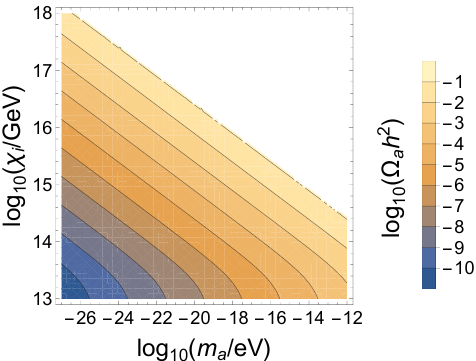
Figure 1. Relic density of ALP dark matter produced through misalignment, the oscillation of which began during the RD epoch, with H M pl = 2 . 44 × 10 18 GeV, Ω r h 2 = 4 . 18 × 10 − 5 . The region shows axion relic density when it does not excess the overall cold dark matter (CDM) density Ω θ i = χ i /f a . Reproduced from [83]. It can be seen that, to constitute a non-negligible fraction of Ω , we should have decay constant f d constant, satisfying PQ broken scenario